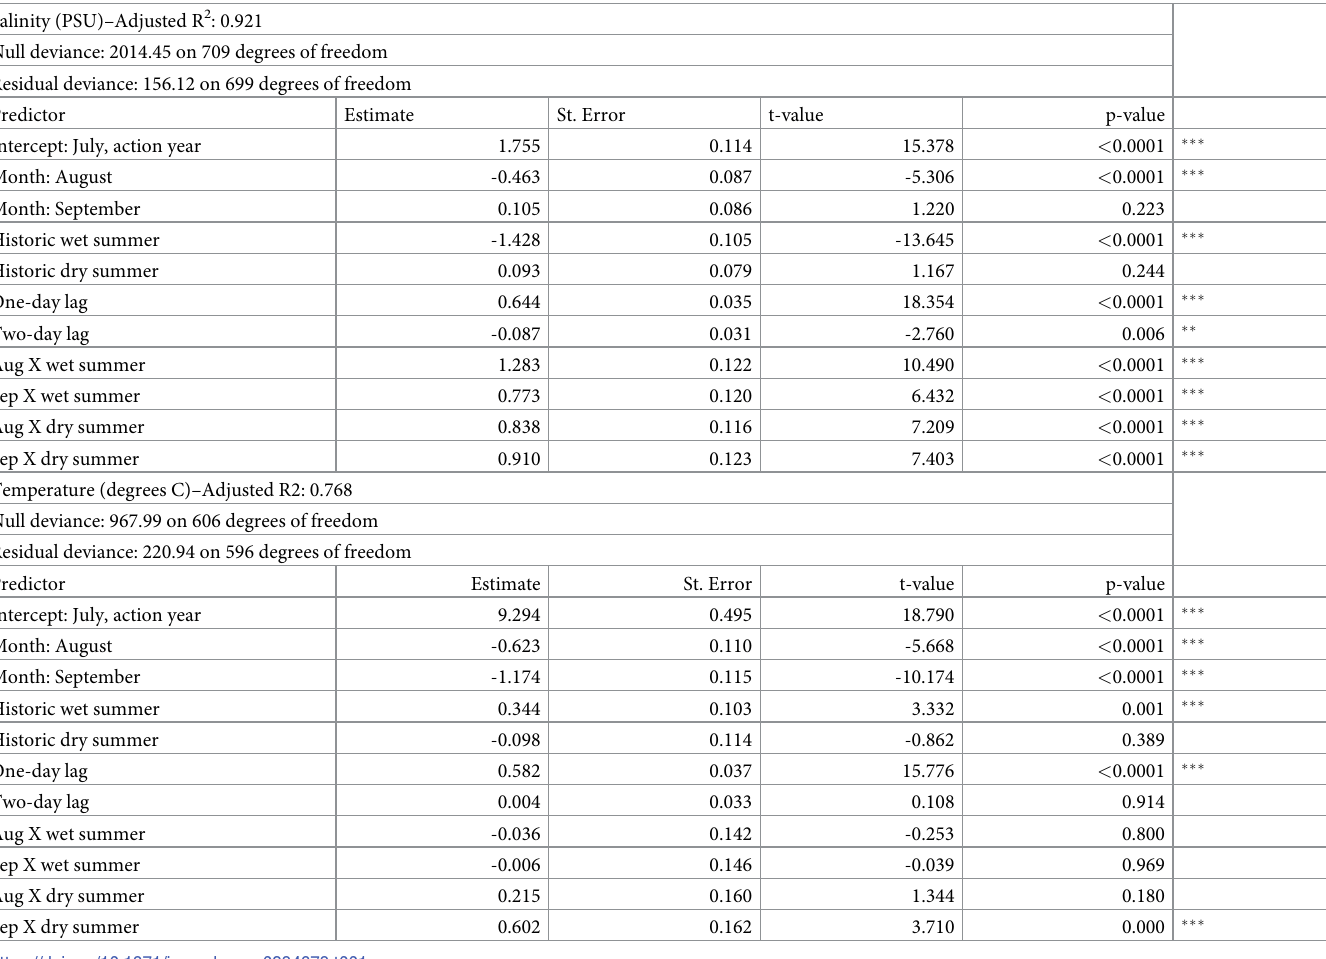
Table 1. Linear model results for salinity and temperature for the action year (2018) versus historical dry (2002; 2009; 2012) and wet (2005; 2006; 2017) summers. Salinity (PSU)–Adjusted R 2 :